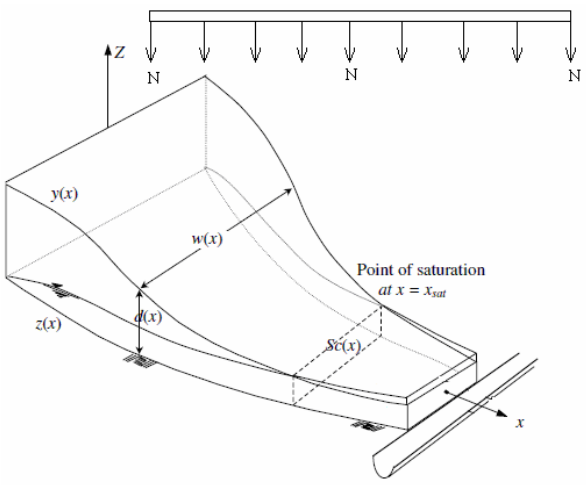
Fig. 4. Relative saturated storage along the nine ba- sic hillslopes for different recharge rates (solid line: N=30mm/day; dashed line: N=20mm/day; dotted line: N=10mm/day). ( k=0 . 0001m / s ,D =2m ,f =0 . 34 ,β =15 ◦